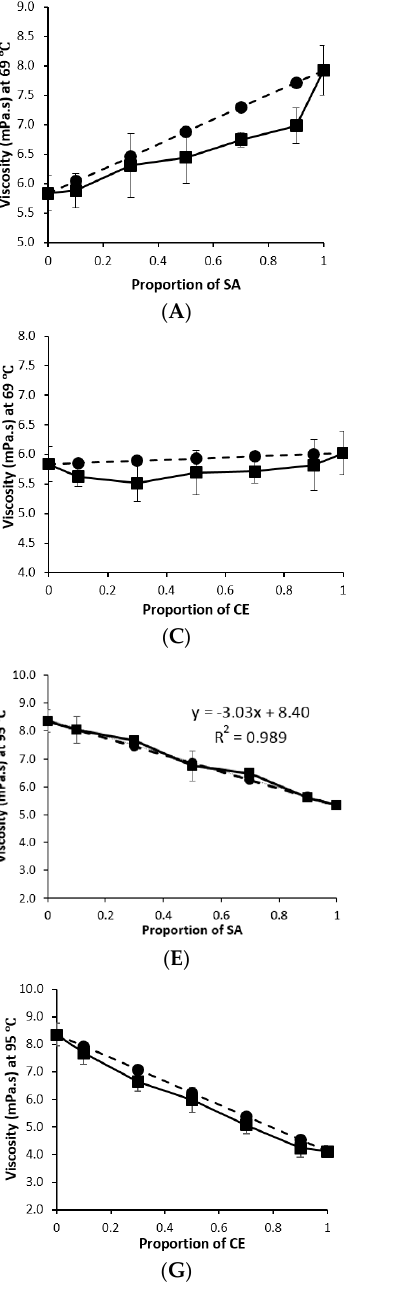
Figure 2. Plots of viscosity ( , solid line) and weighted viscosity ( , dashed line) against proportion of lipid additive in the ( A ) PW59:SA; ( B ) PW59:CA; ( C ) PW59:CE; ( D ) PW84:PW59; ( E ) PW84:SA; ( F ) PW84:CA; ( G ) PW84:CE blends ( n = 3).